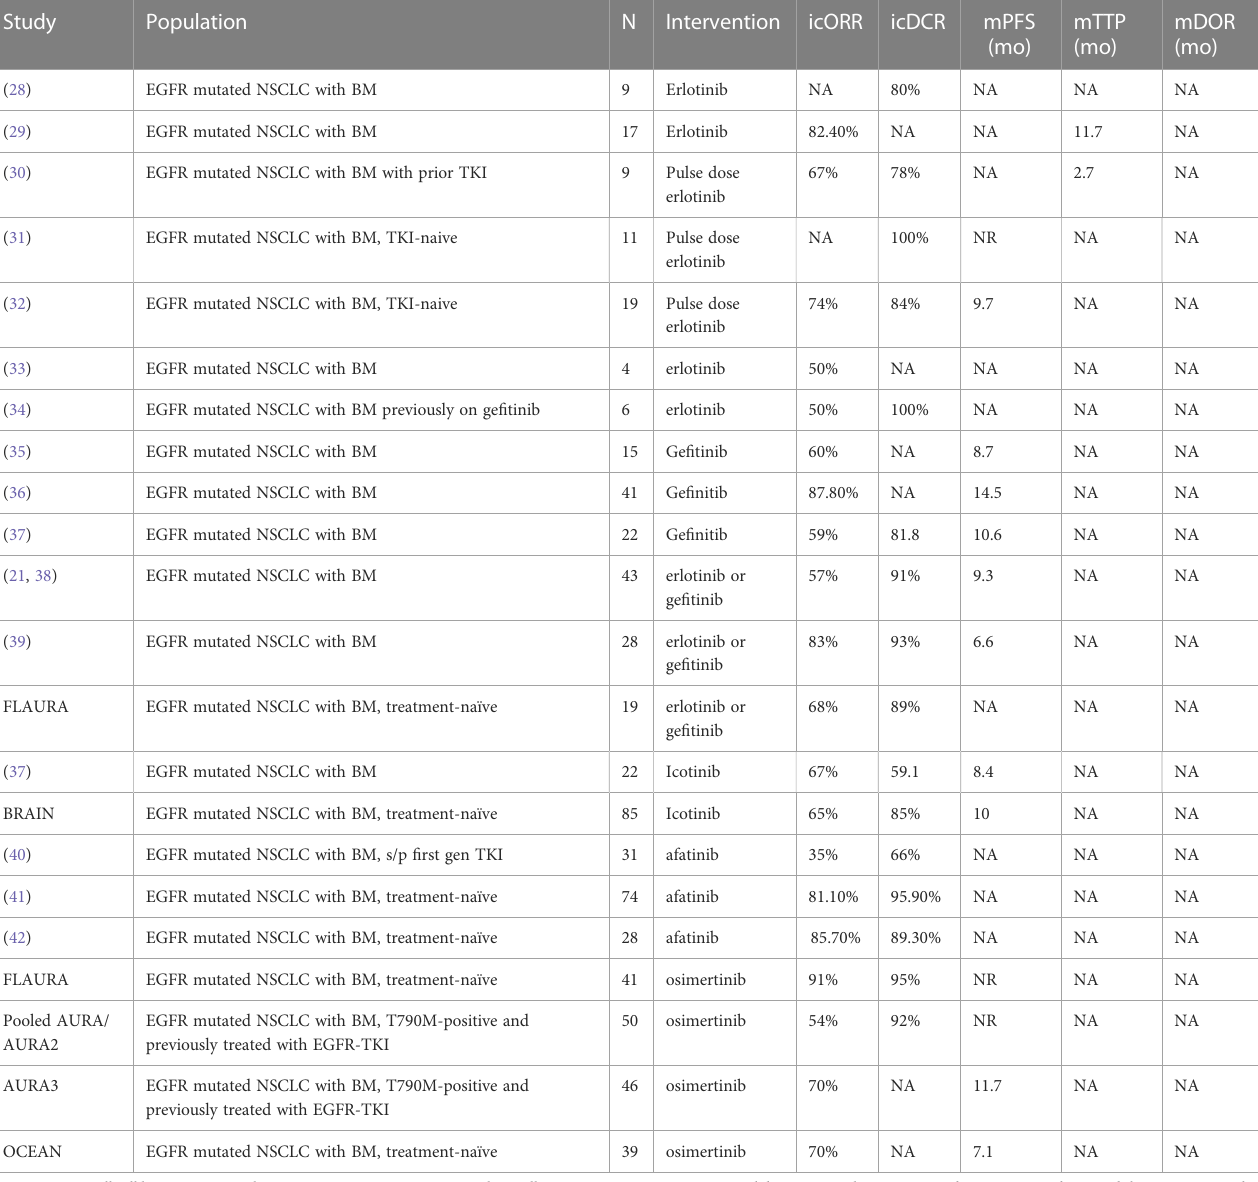
TABLE 1 CNS-related Clinical Outcomes in EGFR-mutated NSCLC with Brain Metastases. Study Population